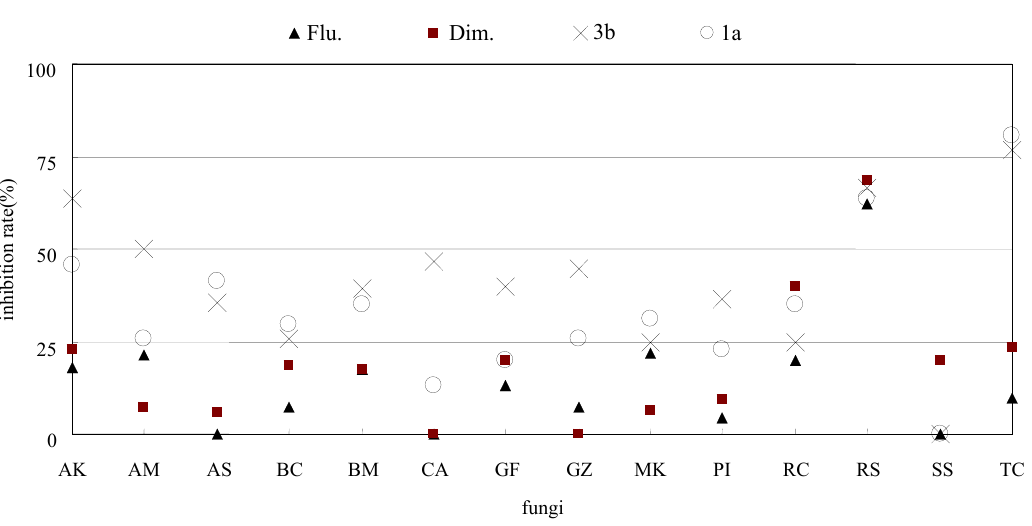
Figure 2. Parallel inhibition rate contrasts between positive controls (flumorph and dimethomorph) and representative pyrimidine derivatives 1a , 3b